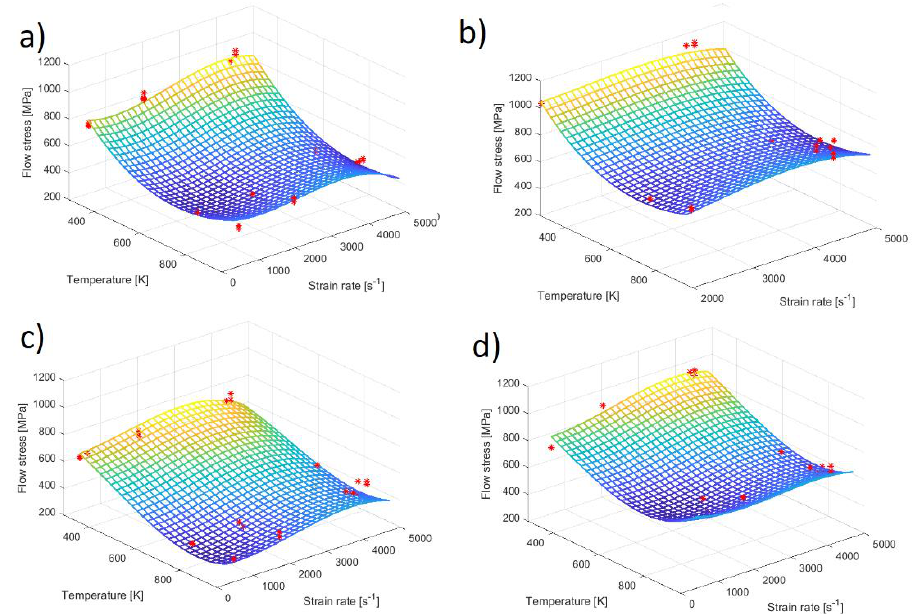
Figure 1 : Flow stress as a function of temperature and strain rate: a) R structure at 2% strain, a) R structure at 20% strain, c) GP structure at 2% strain, and d) G structure at 20% strain